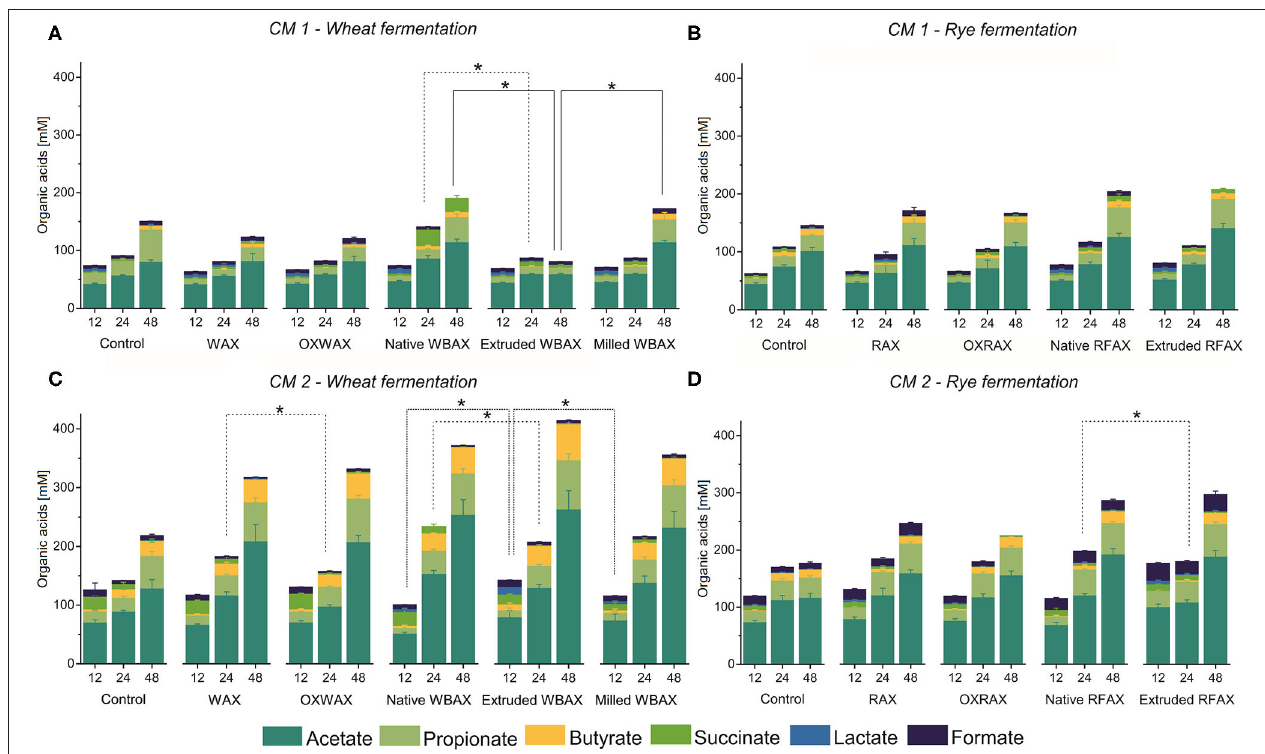
FIGURE 2 | Microbial short-chain fatty acid (SCFA), lactate, and succinate production kinetics during 48h in vitro fermentation of differently processed soluble WBAX and RFAX by CM 1 (A,B) and CM 2 (C,D) . Data are expressed as average ± st dev ( n ≥ 4). Branched SCFA deriving from protein fermentation are displayed in the ( Supplementary Figure 3 ). Significant differences in total organic acids concentration between differently processed AX are indicated at 12, 24, and 48 h, and correspond to α =